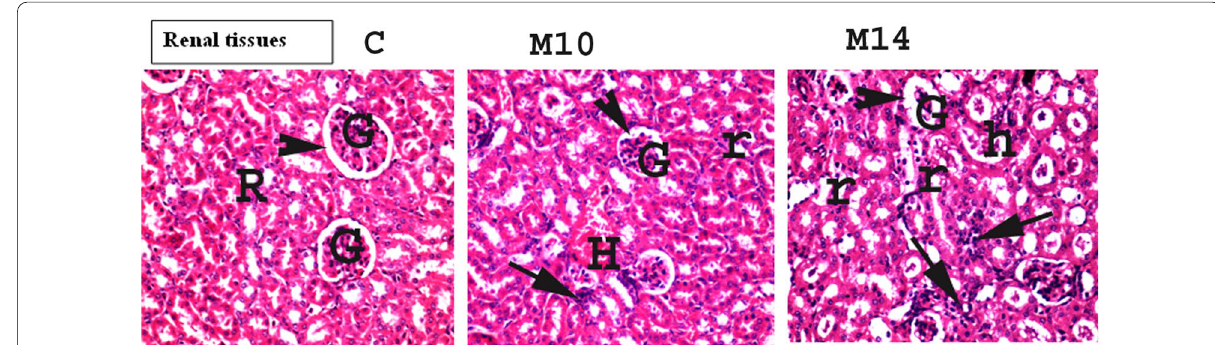
Fig. 4 A photomicrograph of hepatic section. (C) Control group; (M10) monosodium glutamate treated mice for 10 days and (M14) monosodium glutamate treated mice for 14 days. glomerular tuft (G); Bowman’s space(arrow); renal tubules (R); hyaline casts in lumen of tubules (h); severe degenerative change in epithelial cell lining with pyknotic of renal tubules (r); aggregation of inflammatory cells infiltrations (arrow). H